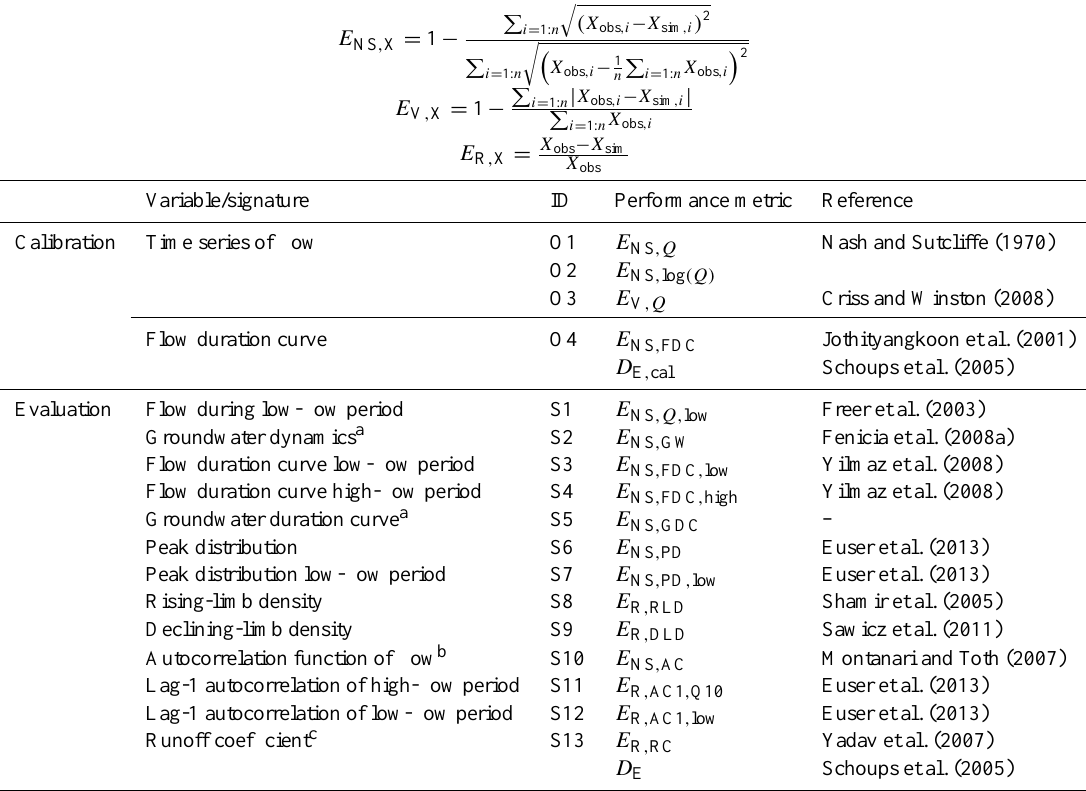
Table 4. Hydrological calibration criteria and evaluation signatures. The performance metrics include the Nash–Sutcliffe efficiency ( E NS ) , the volume error ( E V ) and the relative error ( E R ) . For all variables and signatures, except for Q , Qlow and GW, the long-term averages were